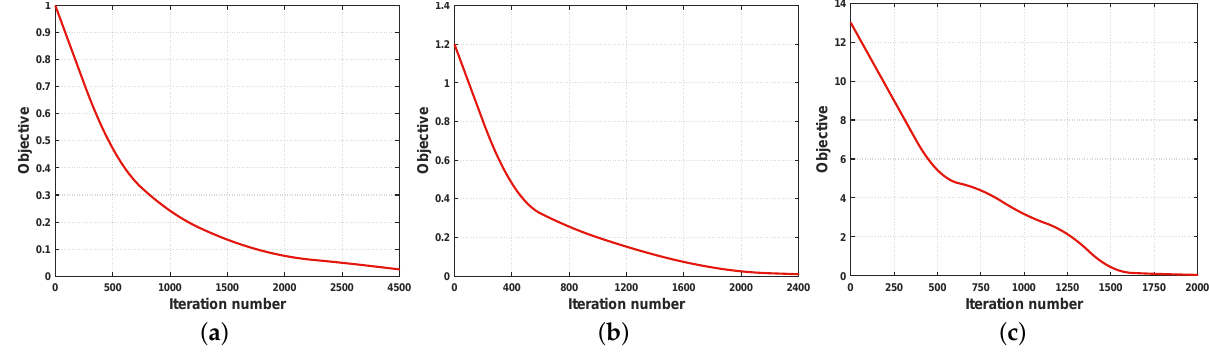
Figure 8. Convergence curves of (cid:105) C on all datasets. ( a ) Corel 5K; ( b ) Pascal Sentence; ( c ) Wiki.